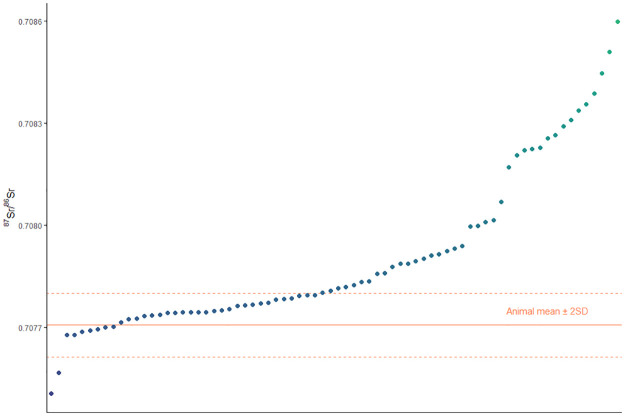
87Sr/86Sr values of all individuals from the archaeological site of Tell el-Dabca.